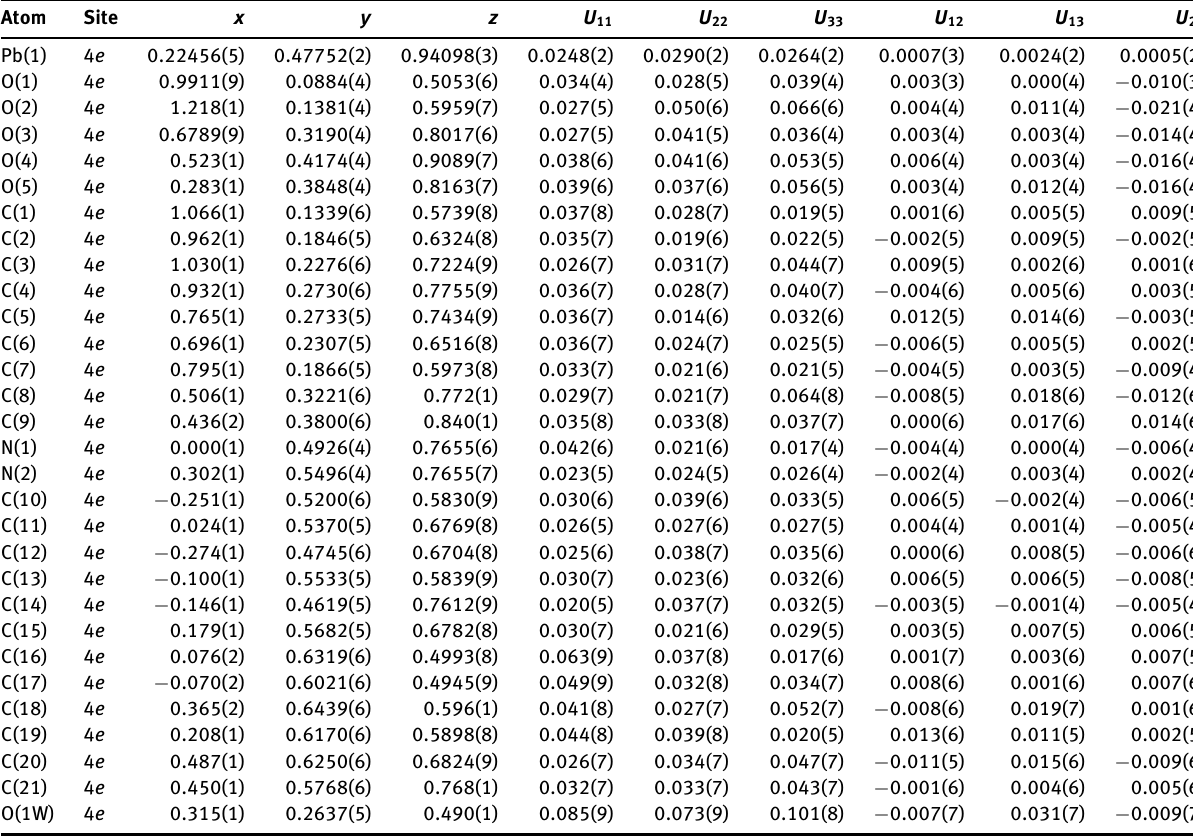
Table 3: Fractional coordinates and atomic displacement parameters (Å 2